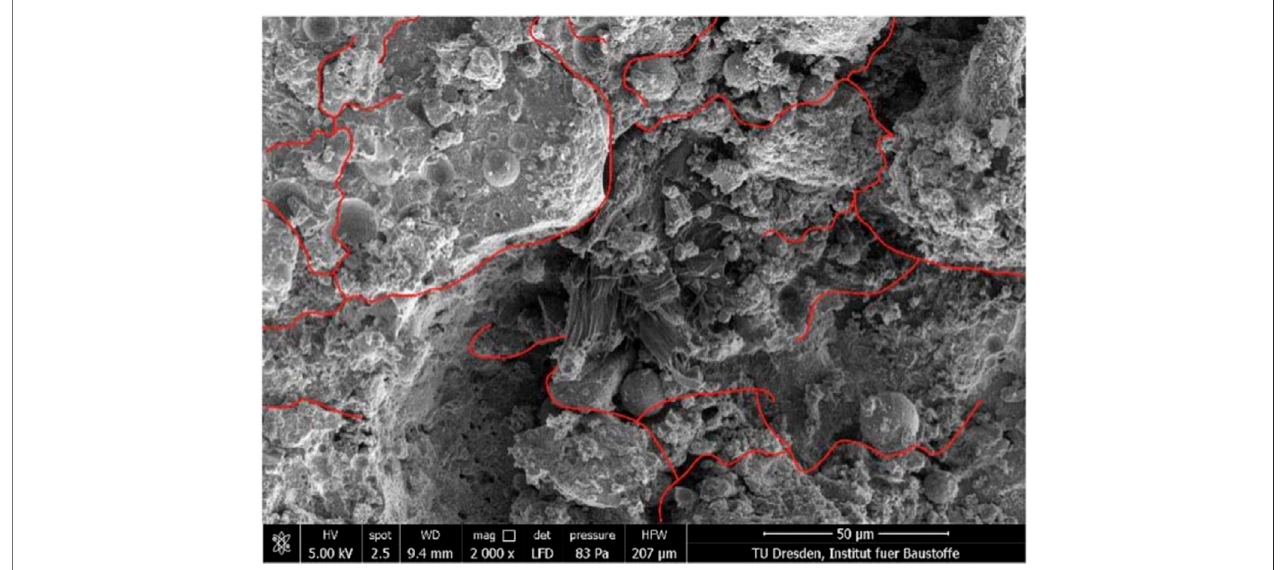
FIGURE 4 | Typical crack surfaces of FRCC under cyclic tensile loading (Müller and Mechtcherine, 2017).